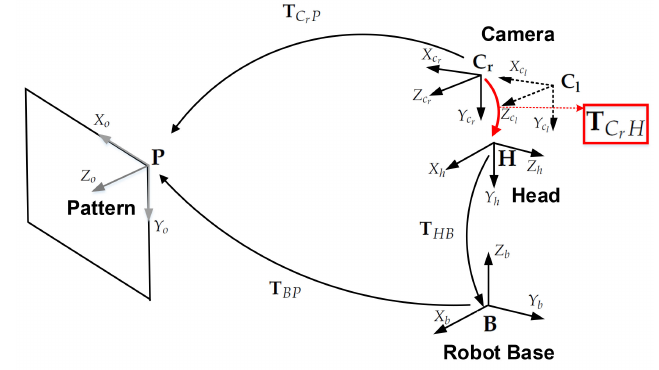
Figure 2. Transformations between coordinates. T C by the red